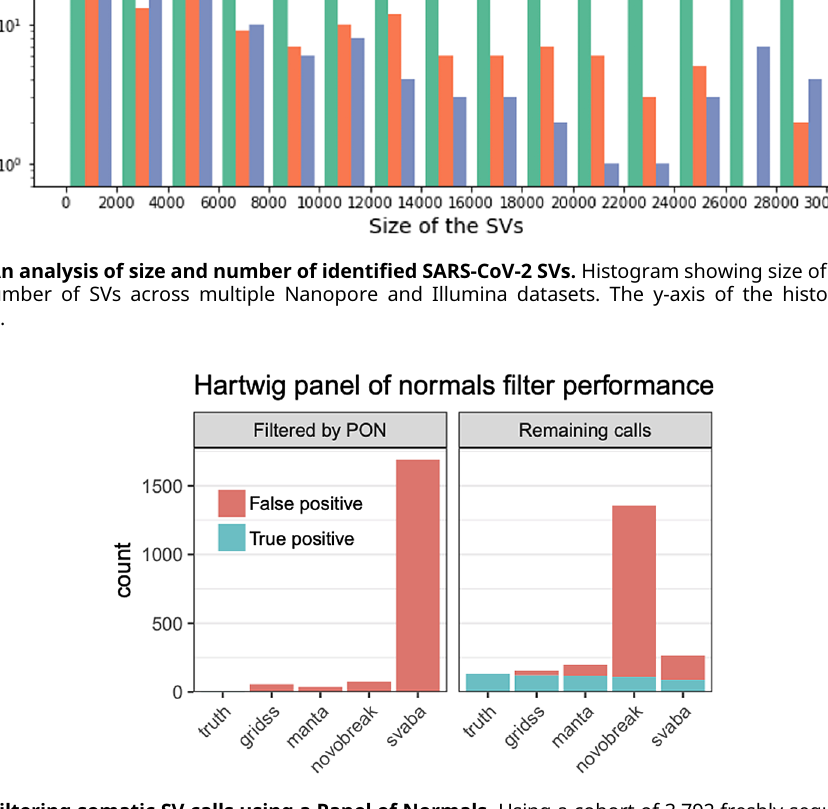
Figure 14. Filtering somatic SV calls using a Panel of Normals. Using a cohort of 3,792 freshly-sequenced WGS normal samples to create a Panel of Normals (PON) from GRIDSS calls and a set of curated calls from sample COLO829toclassifyfalsepositives,wediscoverthatasizeablenumberoffalsepositives werefoundwithinthepanel of normals, suggesting that these were miscategorized due to algorithmic errors. PON filtering based on